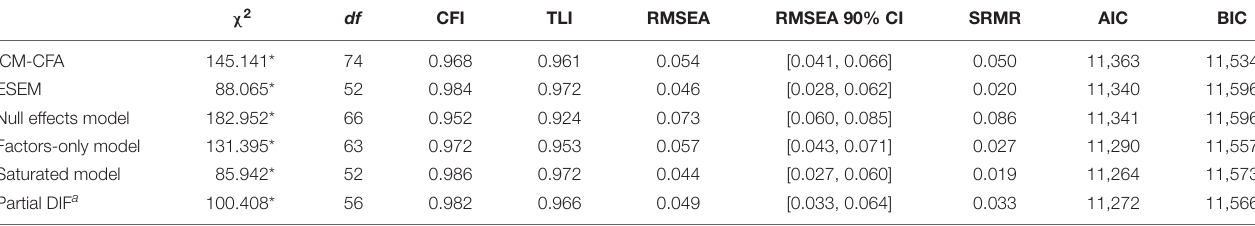
TABLE 6 | Goodness of Fit Statistics and Information Criteria for the ICM-CFA, ESEM, and MIMIC Models (sample 2). χ 2 df CFI TLI RMSEA RMSEA 90% CI SRMR AIC BIC